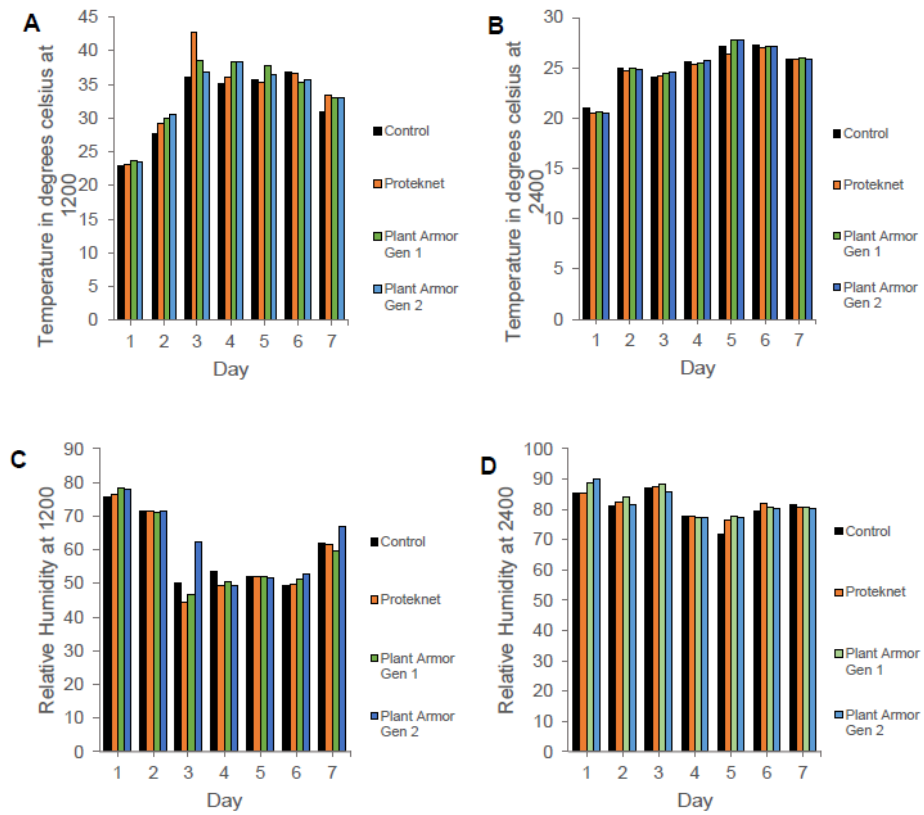
Figure 9. Temperature outside (control) and under Proteknet, Plant Armor Generation (Gen) 1, and Plant Armor Gen 2 at ( A ) 1200 and ( B ) 2400; and percentage humidity outside and under the textile at ( C ) 1200 and ( D ) 2400 over the same 7 days. Sunrise was approximately 7:00 a.m. (0700) and sunset at 7:30 p.m. (1930). Location of measurements under the textiles are shown in Figure 1D.